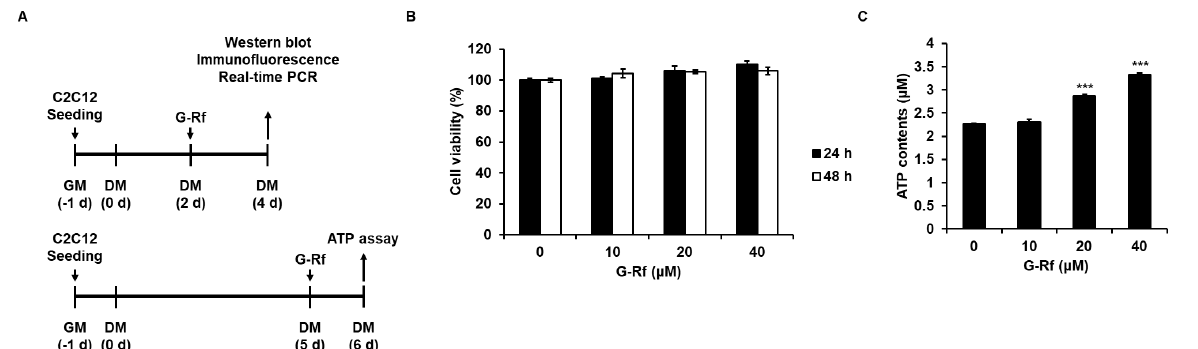
Figure 2. G − Rf enhances ATP levels in murine skeletal C2C12 myotubes. ( A ) Schematic of C2C12 myoblast differentiation experiments. ( B ) C2C12 cells were treated with G − Rf at the indicated concentrations for 24 or 48 h, and then cell viability was investigated using the CCK8 assay. ( C ) C2C12 cells were treated with G − Rf at the indicated concentrations for 24 h and harvested to measure intracellular ATP levels using the colorimetric ATP content assay. Data are expressed as the mean ± standard deviation ( n = 3). *** p < 0.005 compared to untreated myotubes.